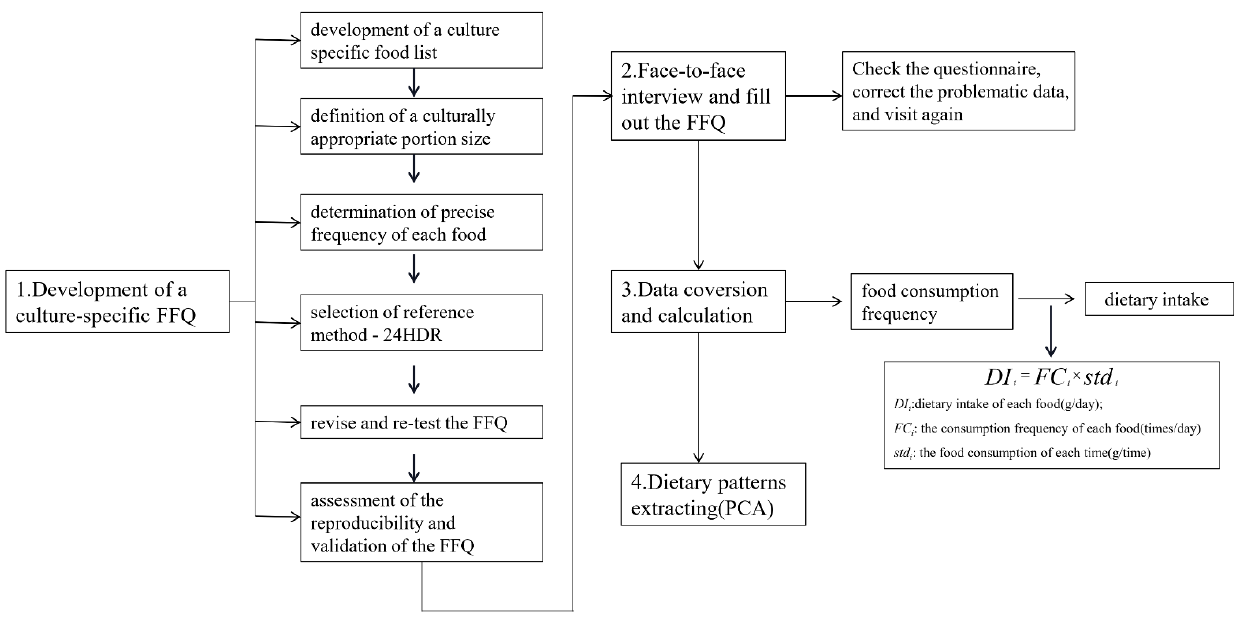
Figure 2. Methodological design for (1) the development of FFQ; (2) interview and fill out the FFQ; (3) data conversion and calculation; (4) dietary patterns extracting FFQ: food frequency questionnaire; 24 HDR: 24 h dietary recall.